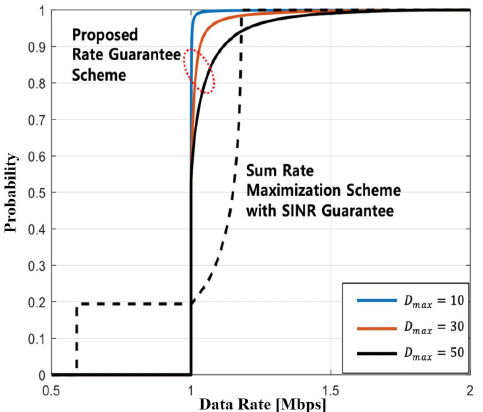
Figure 5. CDF comparison of the proposed rate-guarantee scheme and the sum rate-maximization scheme for different values of (cid:1830) (cid:3040)(cid:3028)(cid:3051) . scheme for di ff erent values of D max .